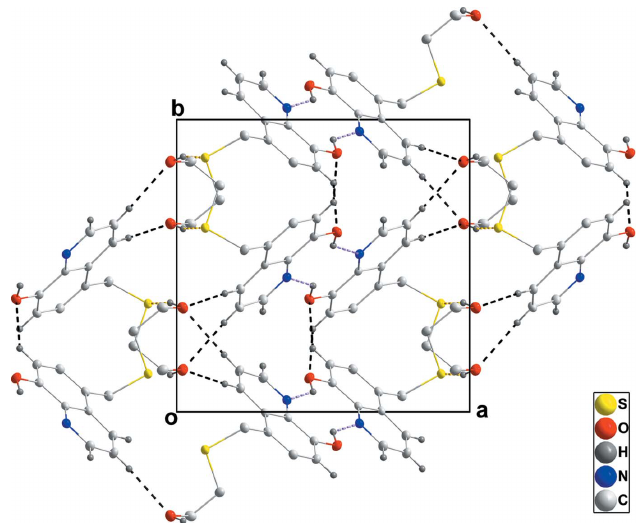
Figure 3 Packing viewed along the c -axis direction with intermolecular inter- actions depicted as in Fig. 2.